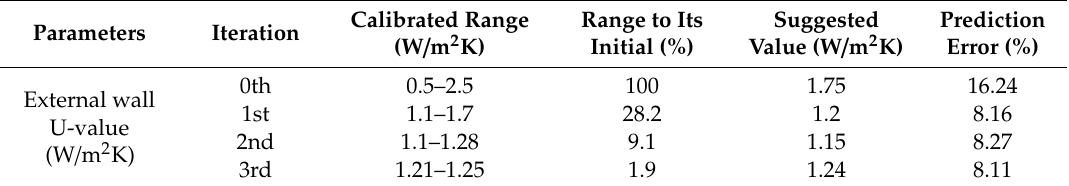
Table 2. Calibration results of each iteration in single parameter